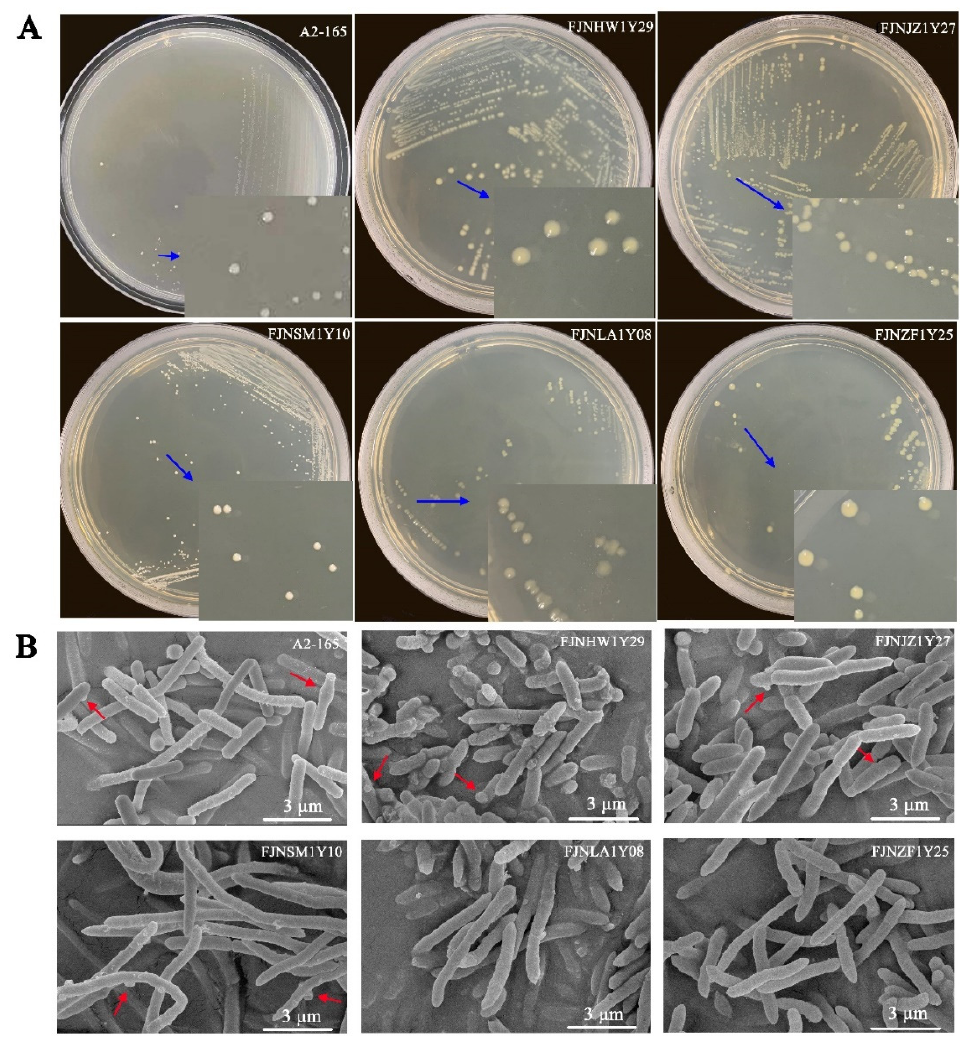
Figure 2. Colony and scanning electron microscopy images of F. prausnitzii strains: ( A ) the colony images of F. prausnitzii isolates and ( B ) the scanning electron microscopy images of F. prausnitzii isolates. The blue arrows show that colonies of F. prausnitzii isolates were 2–4 mm in diameter, circular, and opaque to transparent. The red arrows indicate the special ultrastructure of “swelling”. Scale bars indicate 3 μ m.